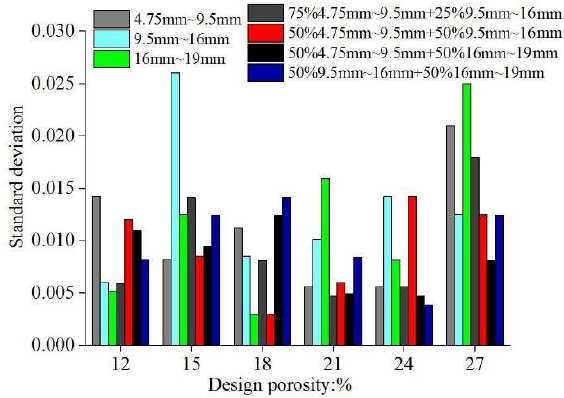
Figure 9. Standard deviation of the permeability coefficient of pervious concrete with different hydraulic gradients. The figure shows the average standard deviation values of three specimens.